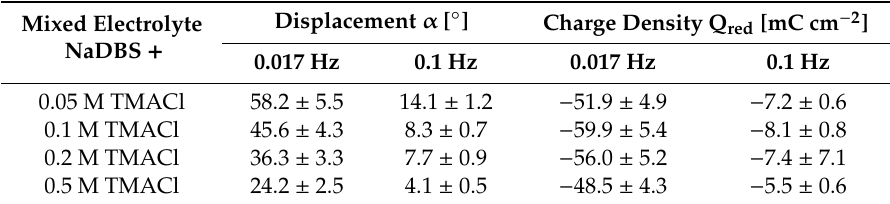
Table 3. PET-PPy bilayer displacement and charge density in mixed electrolytes with constant NaDBS and varied TMACl